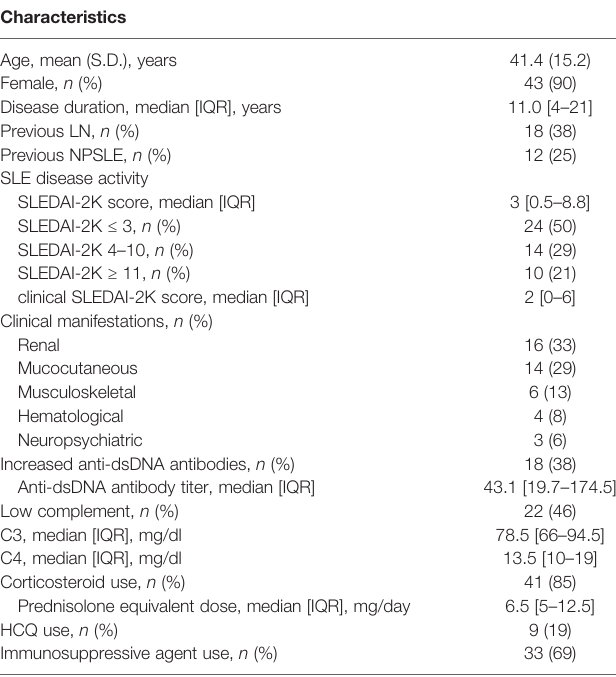
TABLE 1 | Baseline characteristics of SLE